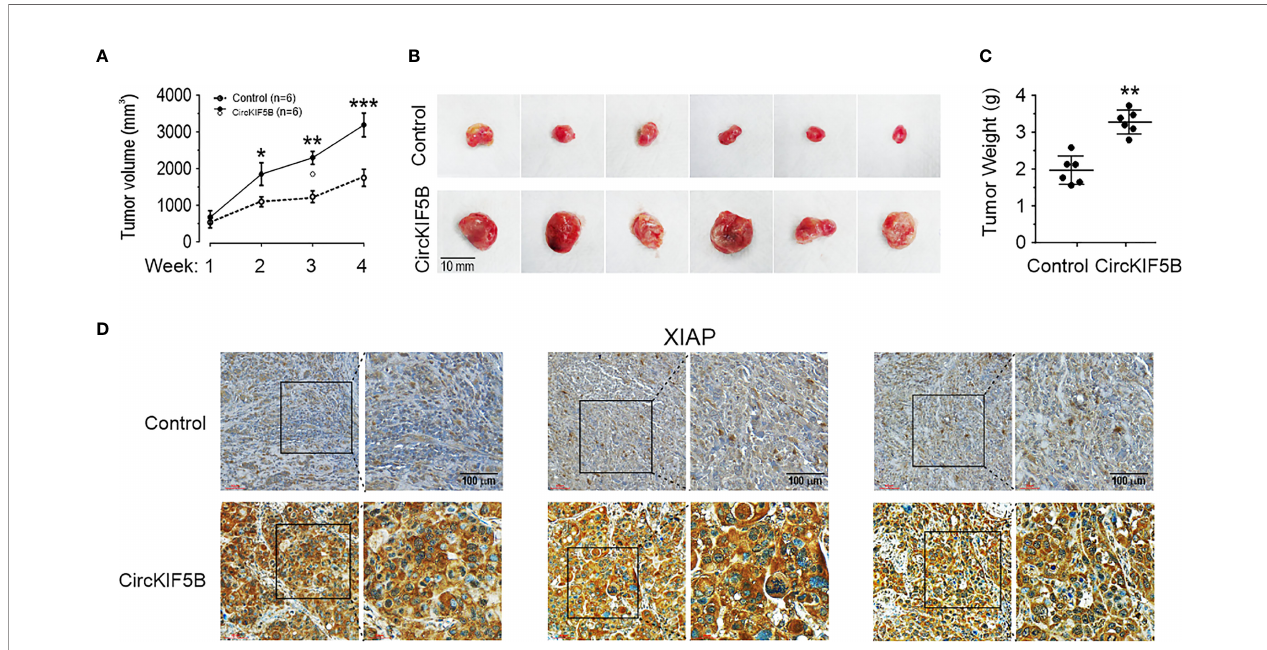
FIGURE 7 | CircKIF5B promotes tumors growth through XIAP signaling. (A) Xenograft assay with HepG2 stable cell lines. Six nude mice were used in each group. (B) Overexpression of circKIF5B increased the volume of the xenograft tumors. (C) Overexpression of circKIF5B increased the weight of the xenograft tumors. (D) IHC staining of xenograft tumor tissues using the XIAP antibodies. *p < 0.05, **p < 0.01, ***P <